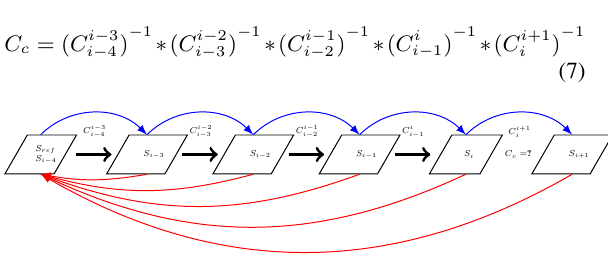
Figure 2. Every incoming scan S i +1 is registered against